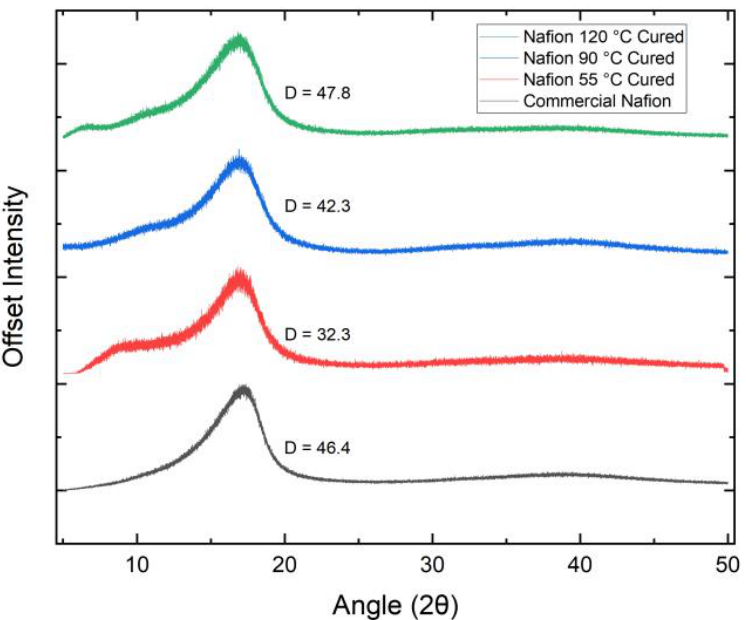
Figure 4. XRD spectra of commercial Nafion and modified Nafion inks cured at different tempera- tures.